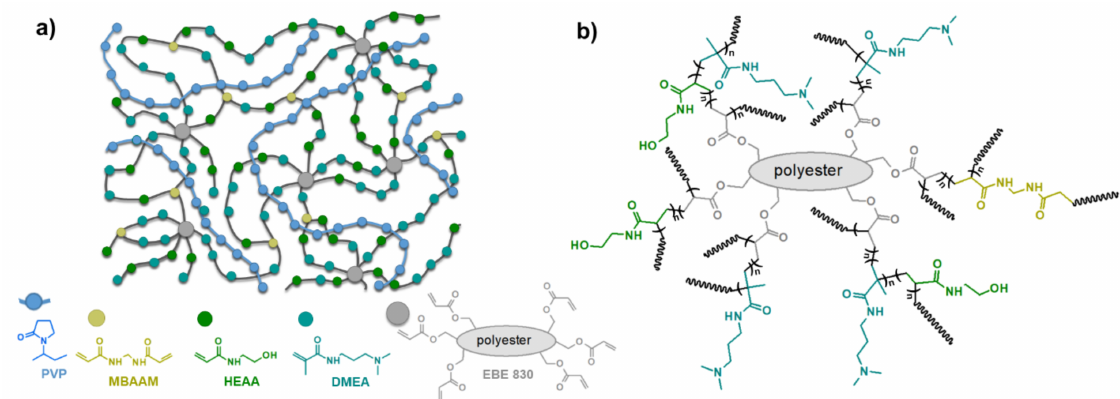
Figure 1. ( a ) Illustrative schematic depiction of the cured IPN of the anion exchange coating layer of the hierarchical membrane. PVP polymer chains (blue) are trapped by entanglement in the crosslinked, UV-cured matrix composed of acrylic resin (grey) and acrylamides (Yellow, green, light blue). ( b ) Depiction of a possible polymer structure of the reacted UV-cured matrix with the chemical structures of the used